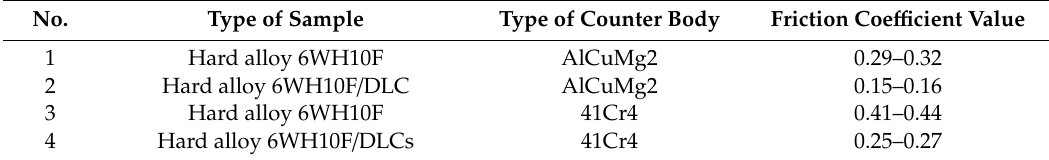
Table 7. Friction coe ffi cient of DLCs deposited on hard alloy